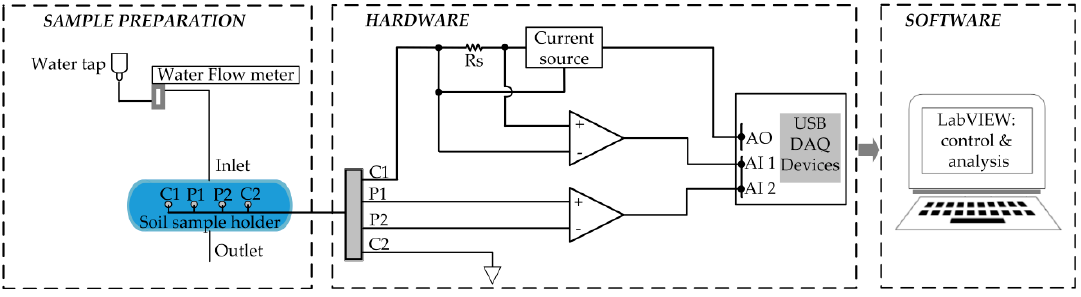
Figure 1. Schematic diagram of the experimental setup.